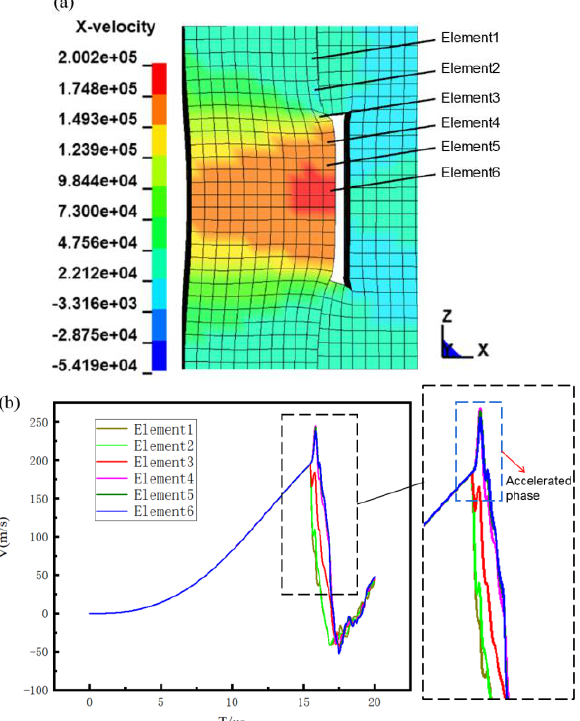
Figure 23. Analysis of element velocity in groove region. ( a ) Trench Deformation Zone Cell Position (16.25 µs). ( b ) Unit speed versus time curve.